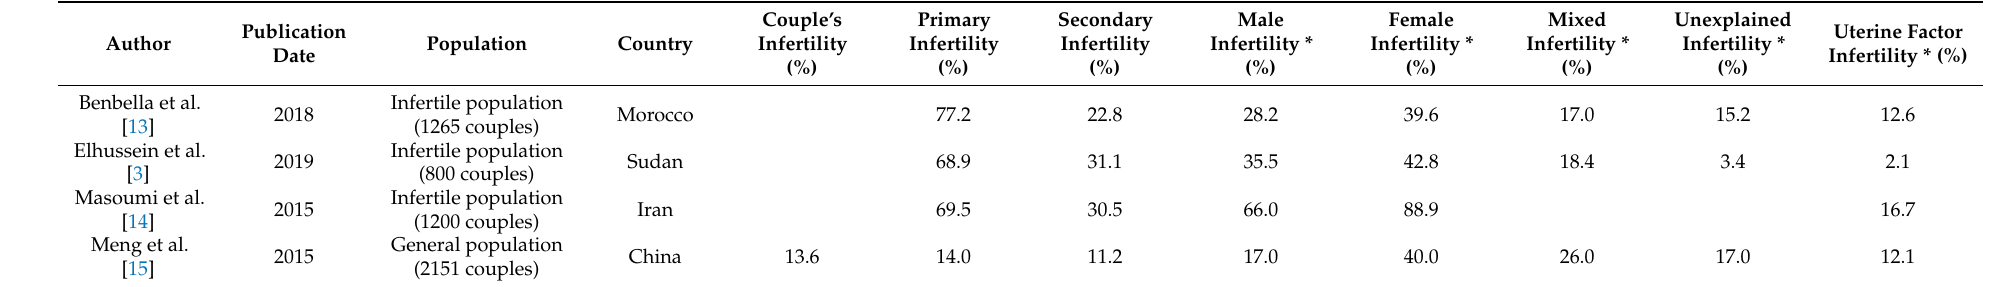
Table 1. Epidemiological data on couple